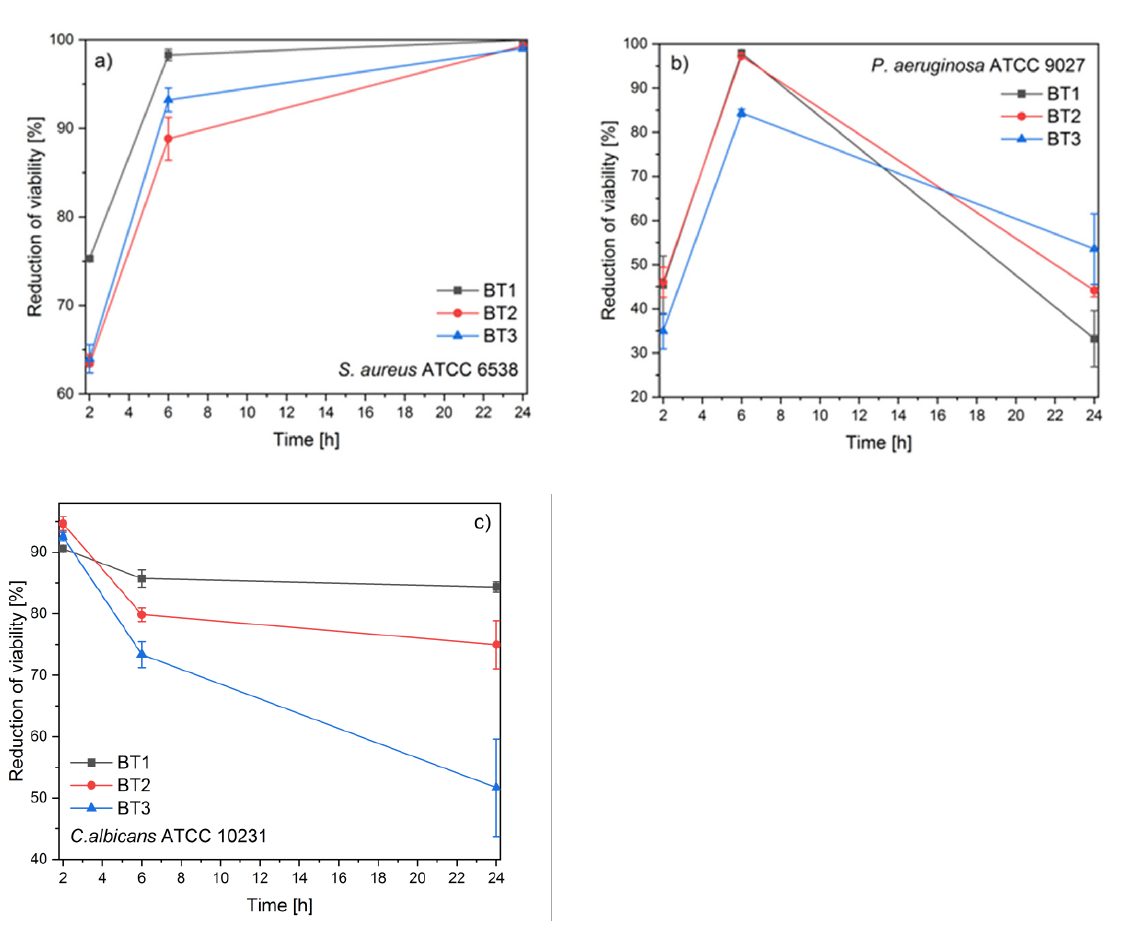
Figure 7. Antimicrobial activity of ZnO NPs against: ( a ) S. aureus, ( b ) P. aeruginosa ; ( c ) C. albicans.